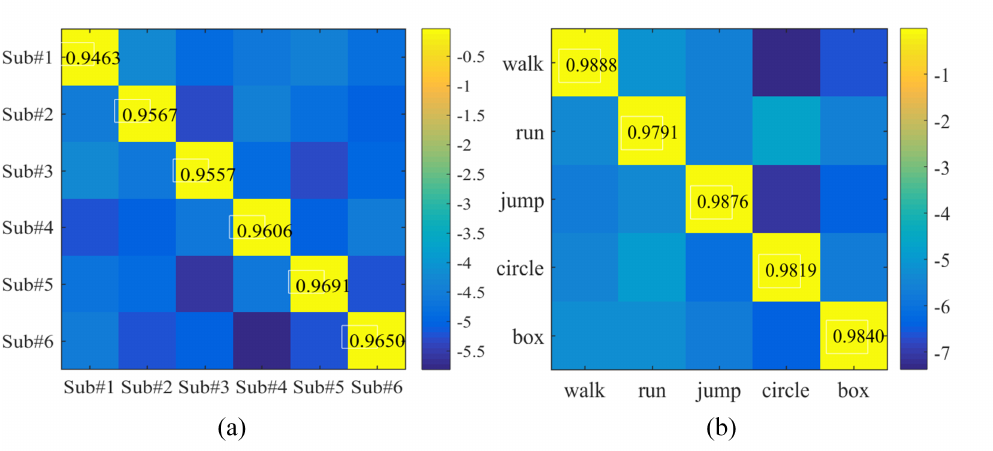
Figure 8. ( a ) Confusion matrix of the person identification task. ( b ) Confusion matrix of the activity recognition task. To illustrate the classification performance more clearly with confusion matrix, color is used to indicate the value log(Recall) instead of Recall .